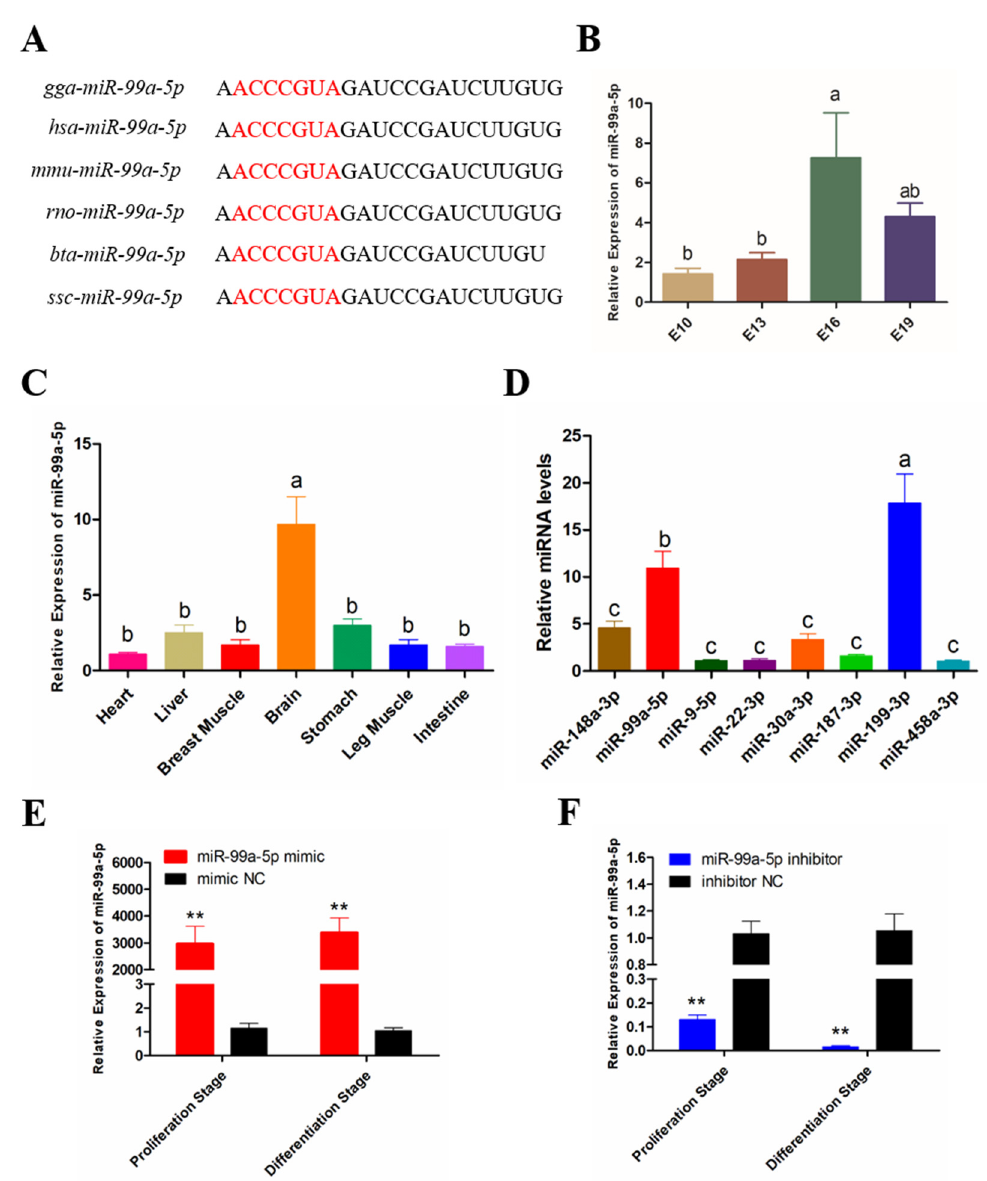
Figure 1. Expression pattern of miR-99a-5p in chicken. ( A ) miR-99a-5p sequence of different species. ( B ) The expression of miR-99a-5p in chicken breast muscle at four embryonic ages. ( C ) The expression of miR-99a-5p in chicken different tissues at embryonic day 16 (E16). ( D ) The expression of eight microRNAs (miRNAs) in chicken breast muscle at E16. ( E ) The transfection efficiency of miR-99a-5p after overexpression of miR-99a-5p. ( F ) The transfection efficiency of miR-99a-5p after inhibition of miR-99a-5p. Results are shown as mean ± standard error of the mean (SEM), and the data are representative of at least three independent assays. One-way ANOVA ( B , C , D ) and Student’s t -test ( E , F ) were used to compare expression levels among different groups. * p < 0.05; ** p < 0.01; a,b p < 0.05.